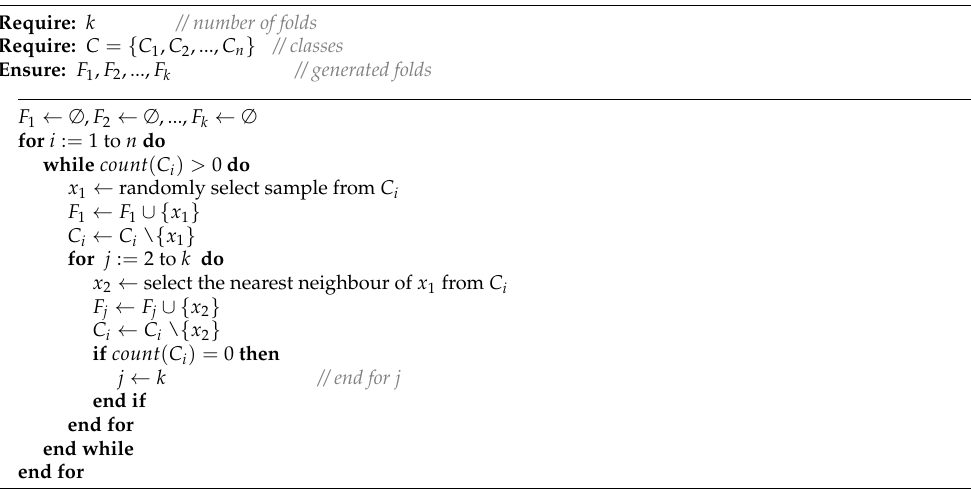
Algorithm 2 Fold generation of DOB-SCV (based on Ref.